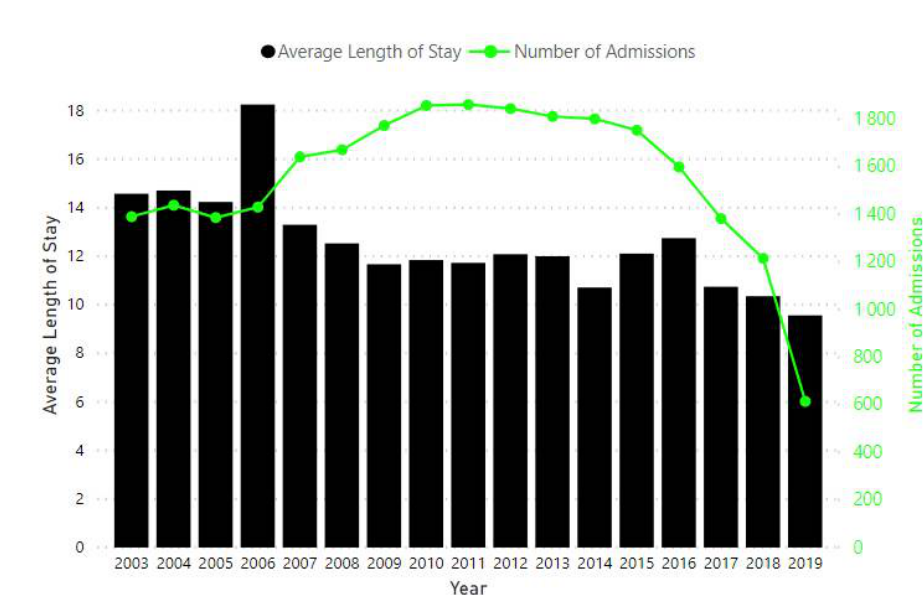
Figure 3. Number of admissions and change in the average length of stay from 2003 to 2019.